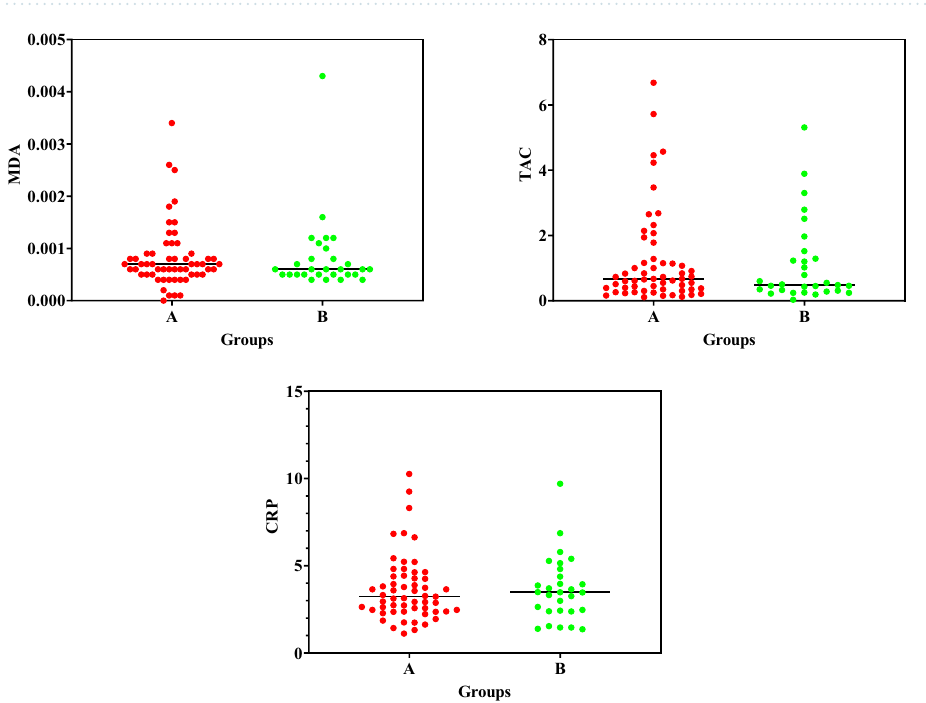
Figure 2. The mean concentrations of MDA (µm/mM cr), TAC (mM/mM cr) in urine samples, and CRP (mg/L) in serum samples among (A) individuals living near restaurants and ( B ) control group